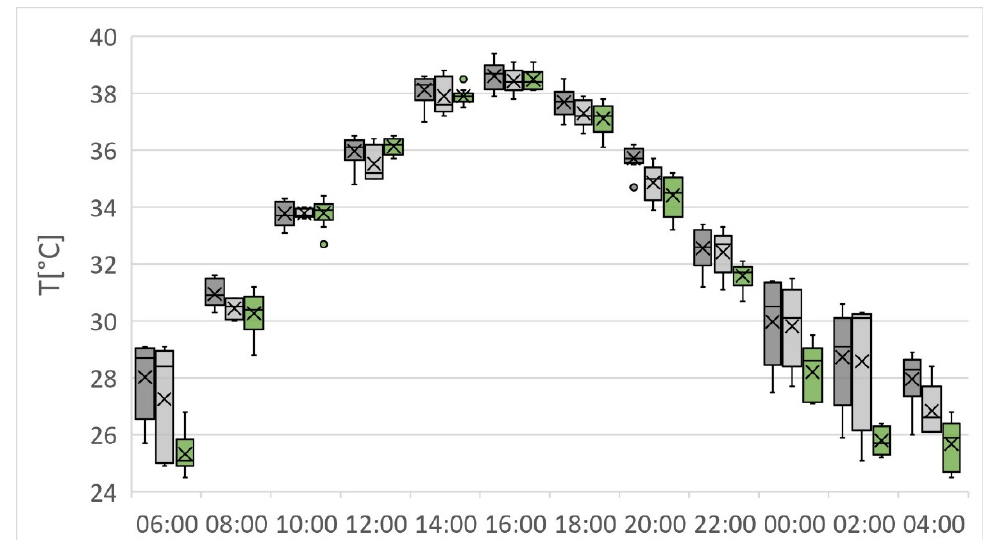
Figure 6. Hourly statistics of LCZ temperature, considering all the sampling points of the two tran- sects; Y axis reports air temperatures in °C. For each value X represents the average, the horizontal line is the median, the box extends from upper to lower quartile. The whiskers (vertical lines outside the box) represent data variability outside the upper and lower quartiles. Points outside the whisker line represent the outlier data.